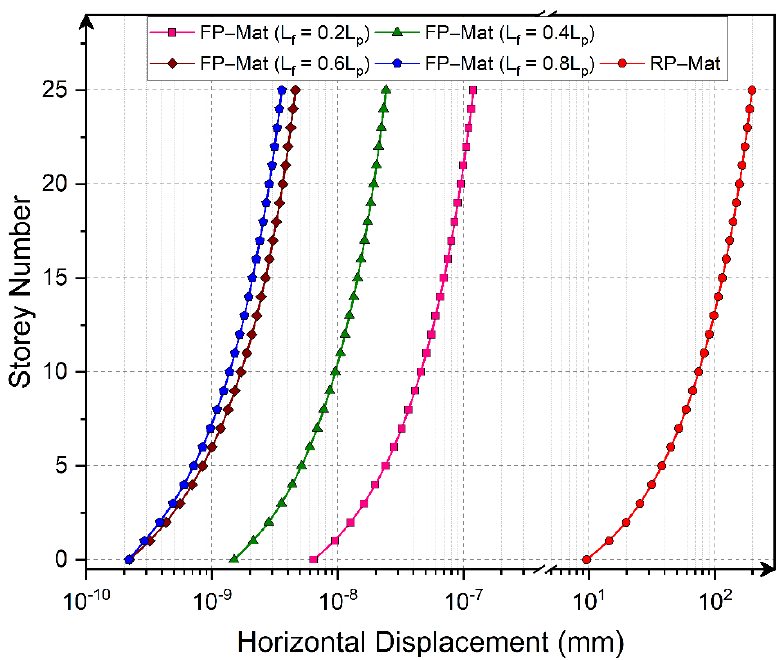
Figure 13. Variation in the peak horizontal displacements for various FP-Mats.